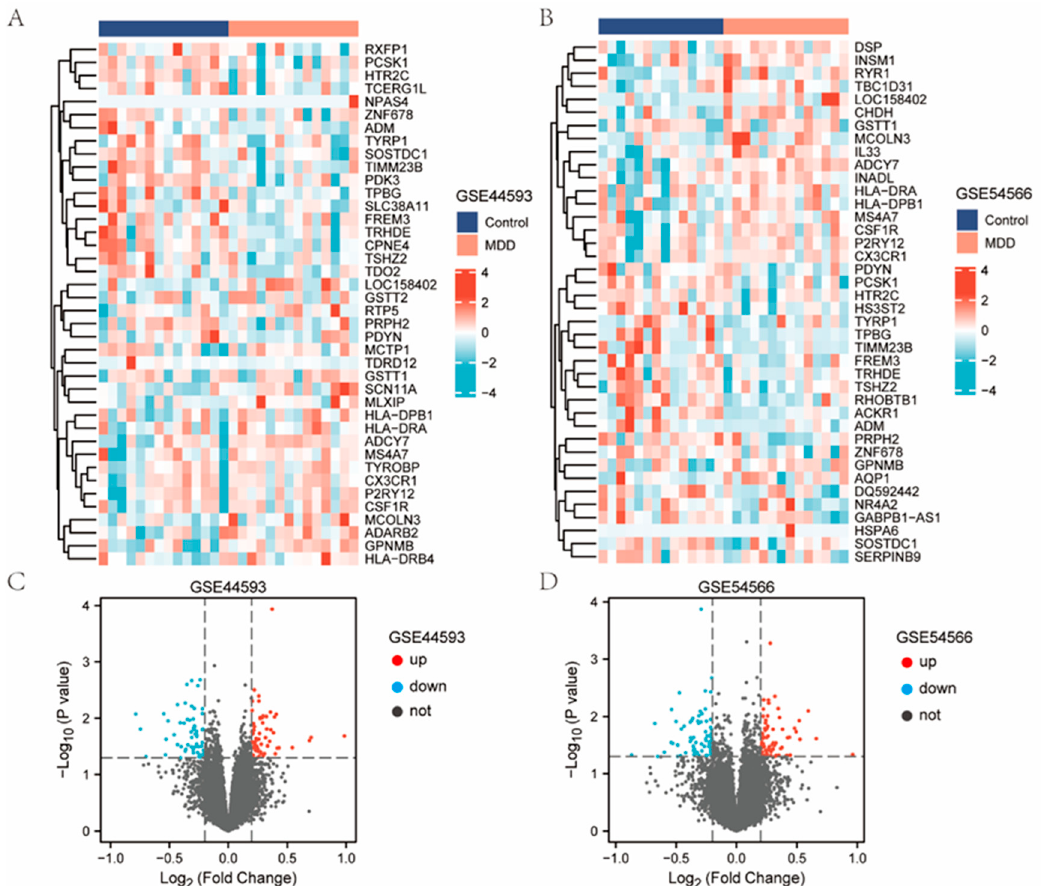
Figure 2. Results of DEGs. ( A ) Heatmap of GSE44593. ( B ) Heatmap of GSE74089. ( C ) Volcano plot of GSE44593. Red represents up-regulation of differential genes, green represents down-regulation of DEGs, and gray represents indifference. ( D ) Volcano plot of GSE54566.